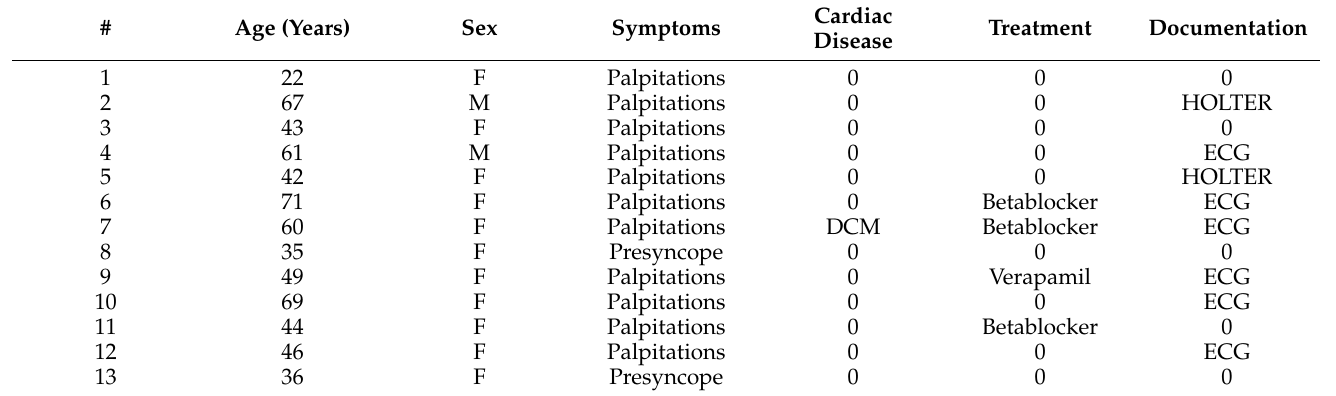
Table 1. Patients’ characteristics.